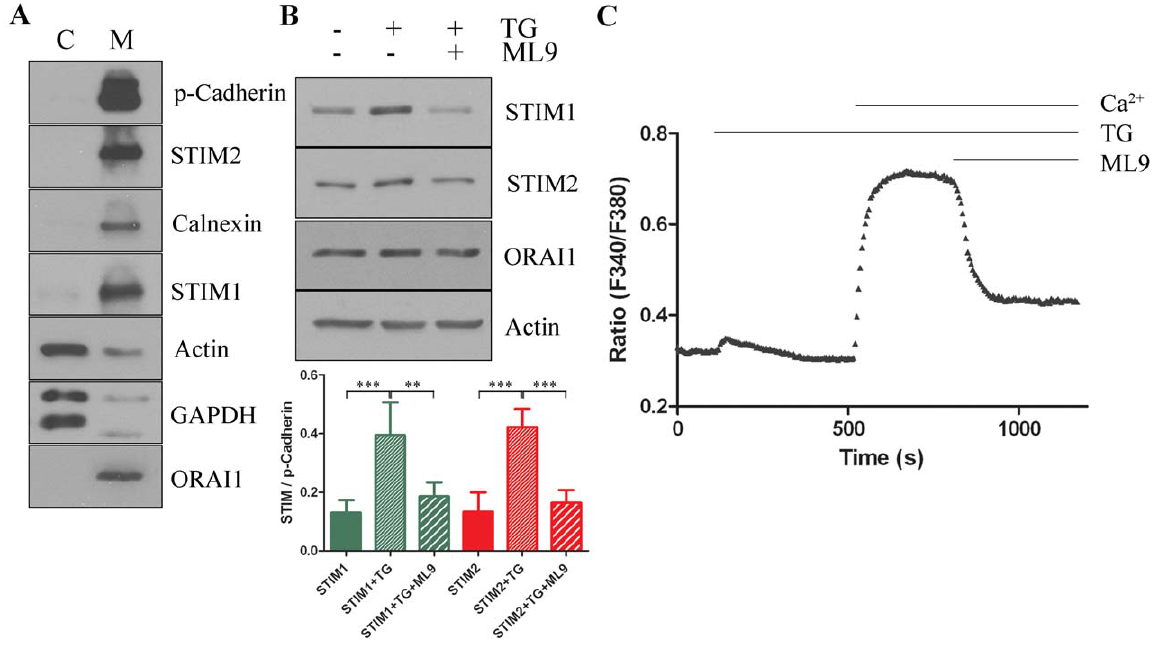
Figure 2. Expression and distribution of endogenous STIM proteins in subcellular neuronal fractions. ( A ) Immunoblots of selected marker proteins demonstrate high separation efficiency for subcellular compartments of neurons on cytosolic (C) and membrane (M) fractions. Proteins were analyzed using the anti-pan Cadherin (plasma membrane), anti-STIM2, anti-Calnexin (ER membrane), anti-STIM1, anti-actin (cytosolic), anti-GAPDH (cytosolic), and anti-ORAI1 antibodies. Notice that STIM and ORAI1 proteins are present only in the membrane fraction. ( B ) Neurons were incubated for 10 min with 2 mM Ca 2 + (left, 2 / 2 ), 2 m M TG in 0.5 mM EGTA (middle, + / 2 ), or 2 m M TG in 0.5 mM EGTA followed by the addition of Ca 2 + in the presence of ML9 for 5 min (right, + / + ). The cells were then subjected to fractionation into cytosolic and membrane fractions, and proteins were analyzed by immunoblotting using anti-STIM1, anti-STIM2, anti-ORAI1, anti-p-Cadherin and anti-actin (loading controls) antibodies. Blots were developed using chemiluminescence. Only membrane subfractions are shown. The image shows the results from one representative experiment. Bars indicate mean 6 SD from at least three separate experiments. STIM1 or STIM2 bands were normalized to the level of loading control p-Cadherin for each immunoblot. ( C ) Effect of ML9 on SOCE of nontransfected neurons after restoration of extracellular Ca 2 + . ML9 was added 5 min after the readdition of 2 mM CaCl 2 . Raw data are shown. The trace represents the average response of cells measured on a single coverslip from two independent